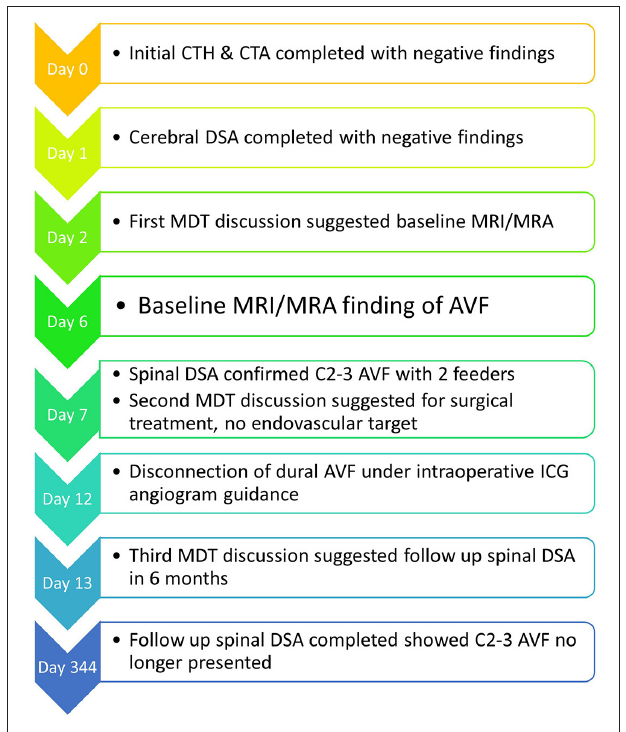
FIGURE 4 | A diagram of timeline for this case.